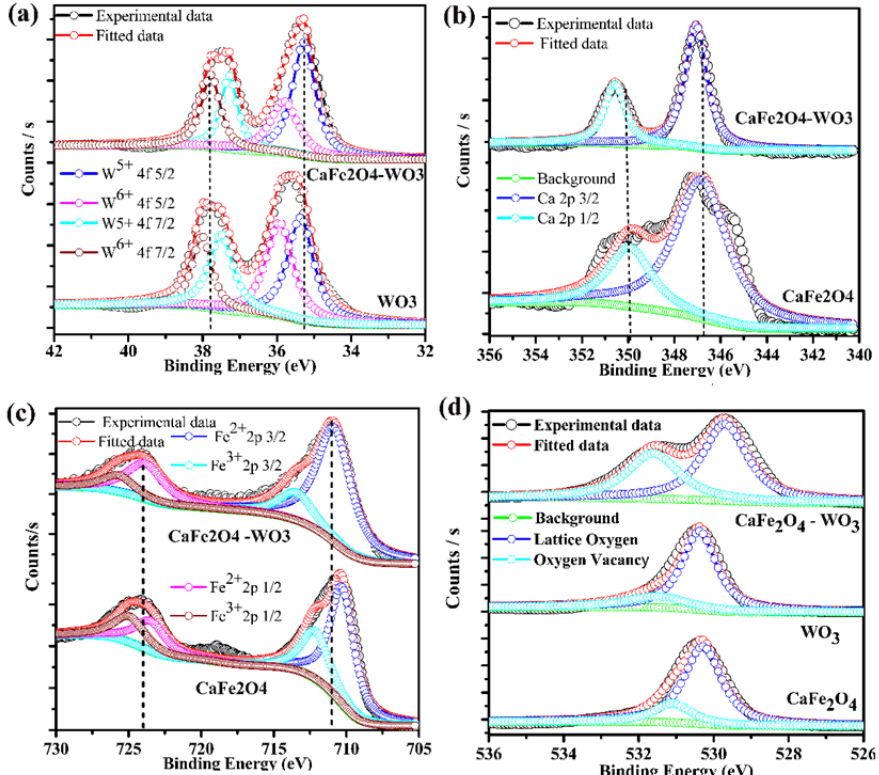
Figure 6. X-ray photoelectron spectra of WO 3 -CaFe 2 O 4 in comparison of pure WO 3 and CaFe 2 O 4 . Figure 6. X ‐ ray photoelectron spectra of WO 3 ‐ CaFe 2 O 4 in comparison of pure WO 3 and CaFe 2 O 4 . ( a ) High ‐ resolution XPS spectra of W ‐ 4f in WO 3 and WO 3 ‐ CaFe 2 O 4 , ( b , c ) Ca ‐ 2p and Fe ‐ 2p XPS spectra ( a ) High-resolution XPS spectra of W-4f in WO 3 and WO 3 -CaFe 2 O 4 , ( b , c ) Ca-2p and Fe-2p XPS of CaFe 2 O 4 and WO 3 ‐ CaFe 2 O 4 , respectively, and ( d ) O1s XPS spectra of CaFe 2 O 4 , WO 3, and WO 3 ‐ spectra of CaFe 2 O 4 and WO 3 -CaFe 2 O 4 , respectively, and ( d ) O1s XPS spectra of CaFe 2 O 4 , WO 3, and CaFe 2 O 4 , respectively. WO 3 -CaFe 2 O 4 ,